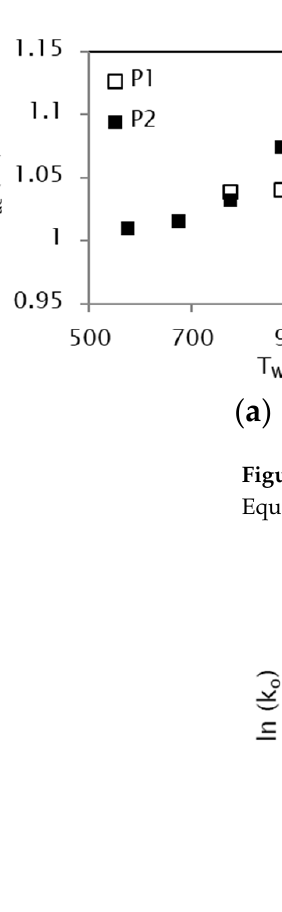
Figure 8. [ ln ( dx / dt ) − ln ( 1 − x )] vs. ( 1/ T ) lines corresponding to P 2 (full lines) and P 1 (dotted lines), Figure 8. (cid:4670)𝑙𝑛(𝑑𝑥 𝑑𝑡⁄ ) − 𝑙𝑛(1 − 𝑥)(cid:4671) vs. (1 𝑇⁄ ) lines corresponding to P 2 (full lines) and P 1 (dotted for Cu 5 samples quenched from different T WQ temperatures. lines), for Cu 5 samples quenched from different T WQ temperatures.